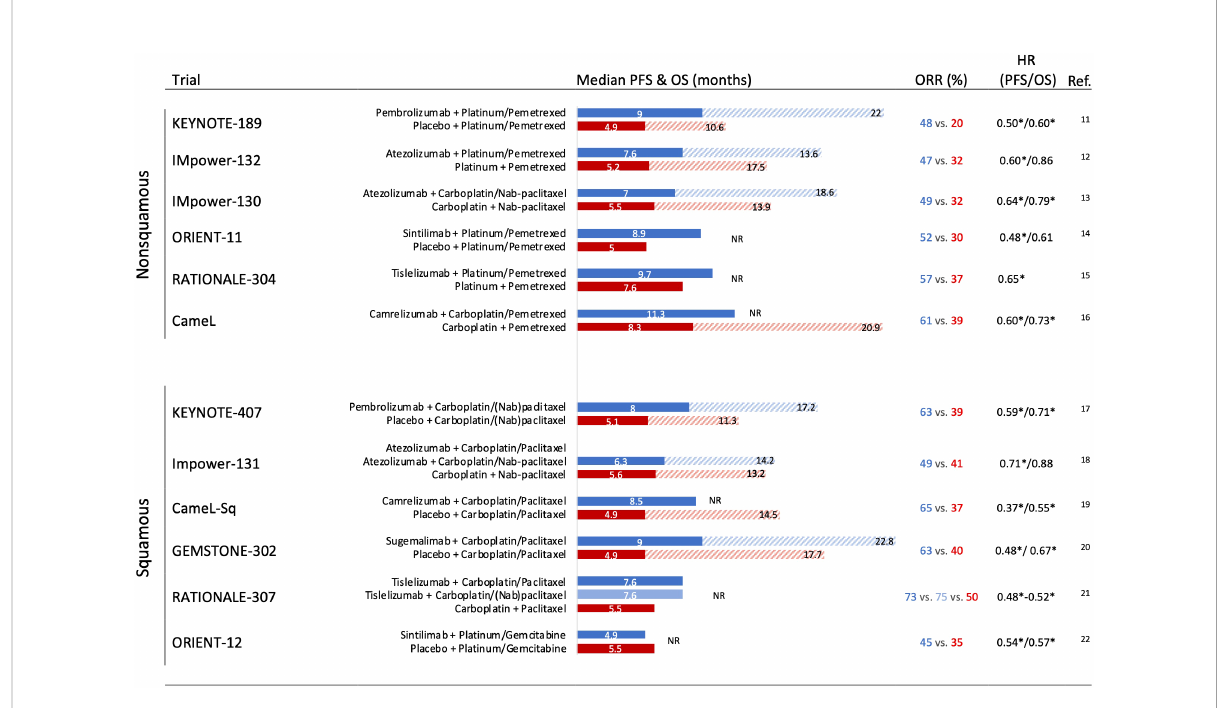
FIGURE 1 Phase III trials assessing an immune checkpoint inhibitor + chemotherapy strategies in the fi rst-line setting in nonsquamous and squamous non-small cell lung cancer with outcomes. HR, hazard ratio; OS, overall survival; PFS, progression-free survival; ORR, overall response rate; NR, not reached (overall survival). * Signi fi cant